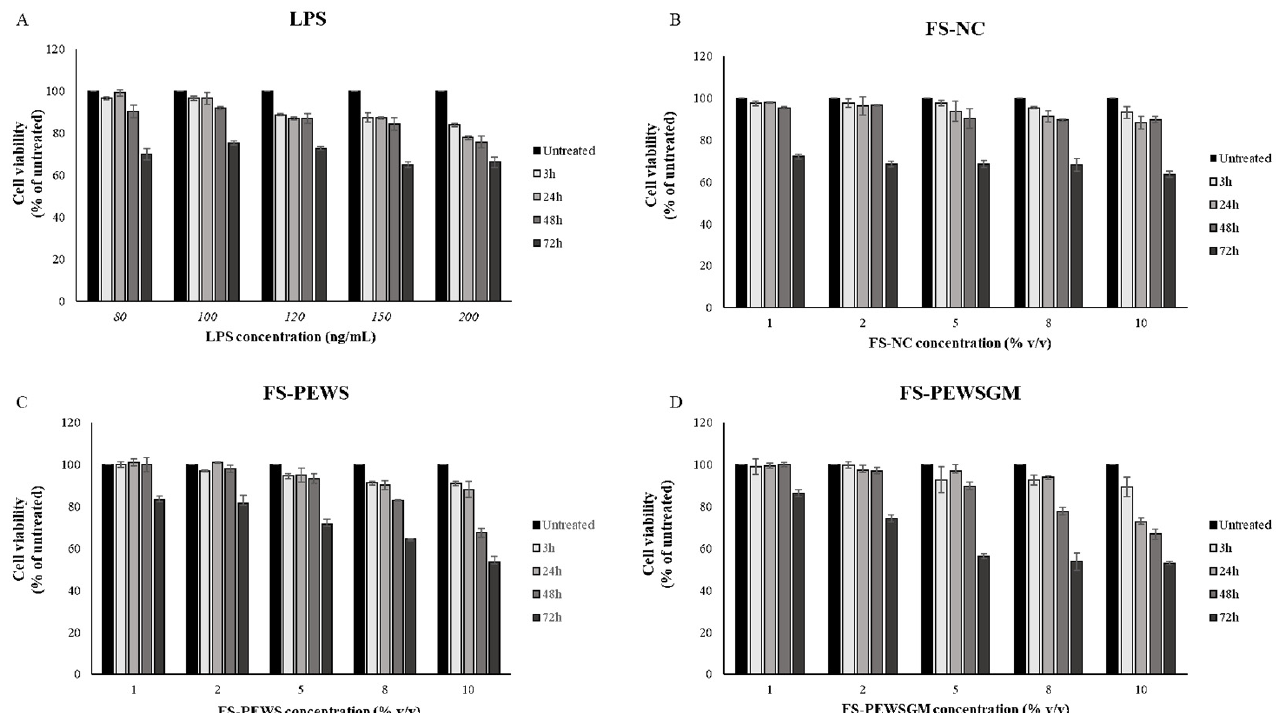
Figure 1. Effects of lipopolysaccharides (LPS) and FSs (FS-NC, FS-PEWS and FS-PEWSGM) on Caco-2 cell viability. Caco-2 cells were seeded in a 6-well plate and treated with ( A ) LPS at concentrations of 80, 100, 120, 150 and 200 ng/mL for 3, 24, 48 and 72 h, ( B ) FS-NC at concentrations of 1%, 2%, 5%, 8% and 10% for 3, 24, 48 and 72 h, ( C ) FS-PEWS at concentrations of 1%, 2%, 5%, 8% and 10% for 3, 24, 48 and 72 h, and ( D ) FS-PEWSGM at concentrations of 1%, 2%, 5%, 8% and 10% for 3, 24, 48 and 72 h. Values are mean ± SD of three independent experiments.